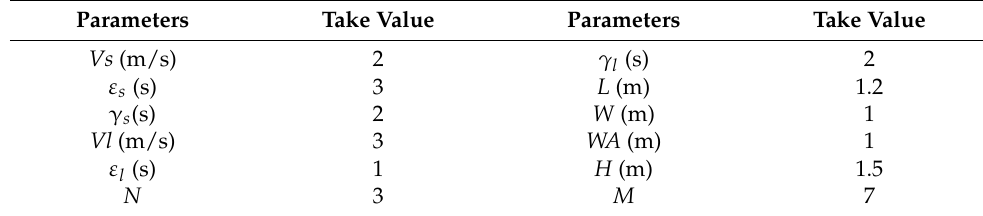
Table 4. Simulation parameter values.